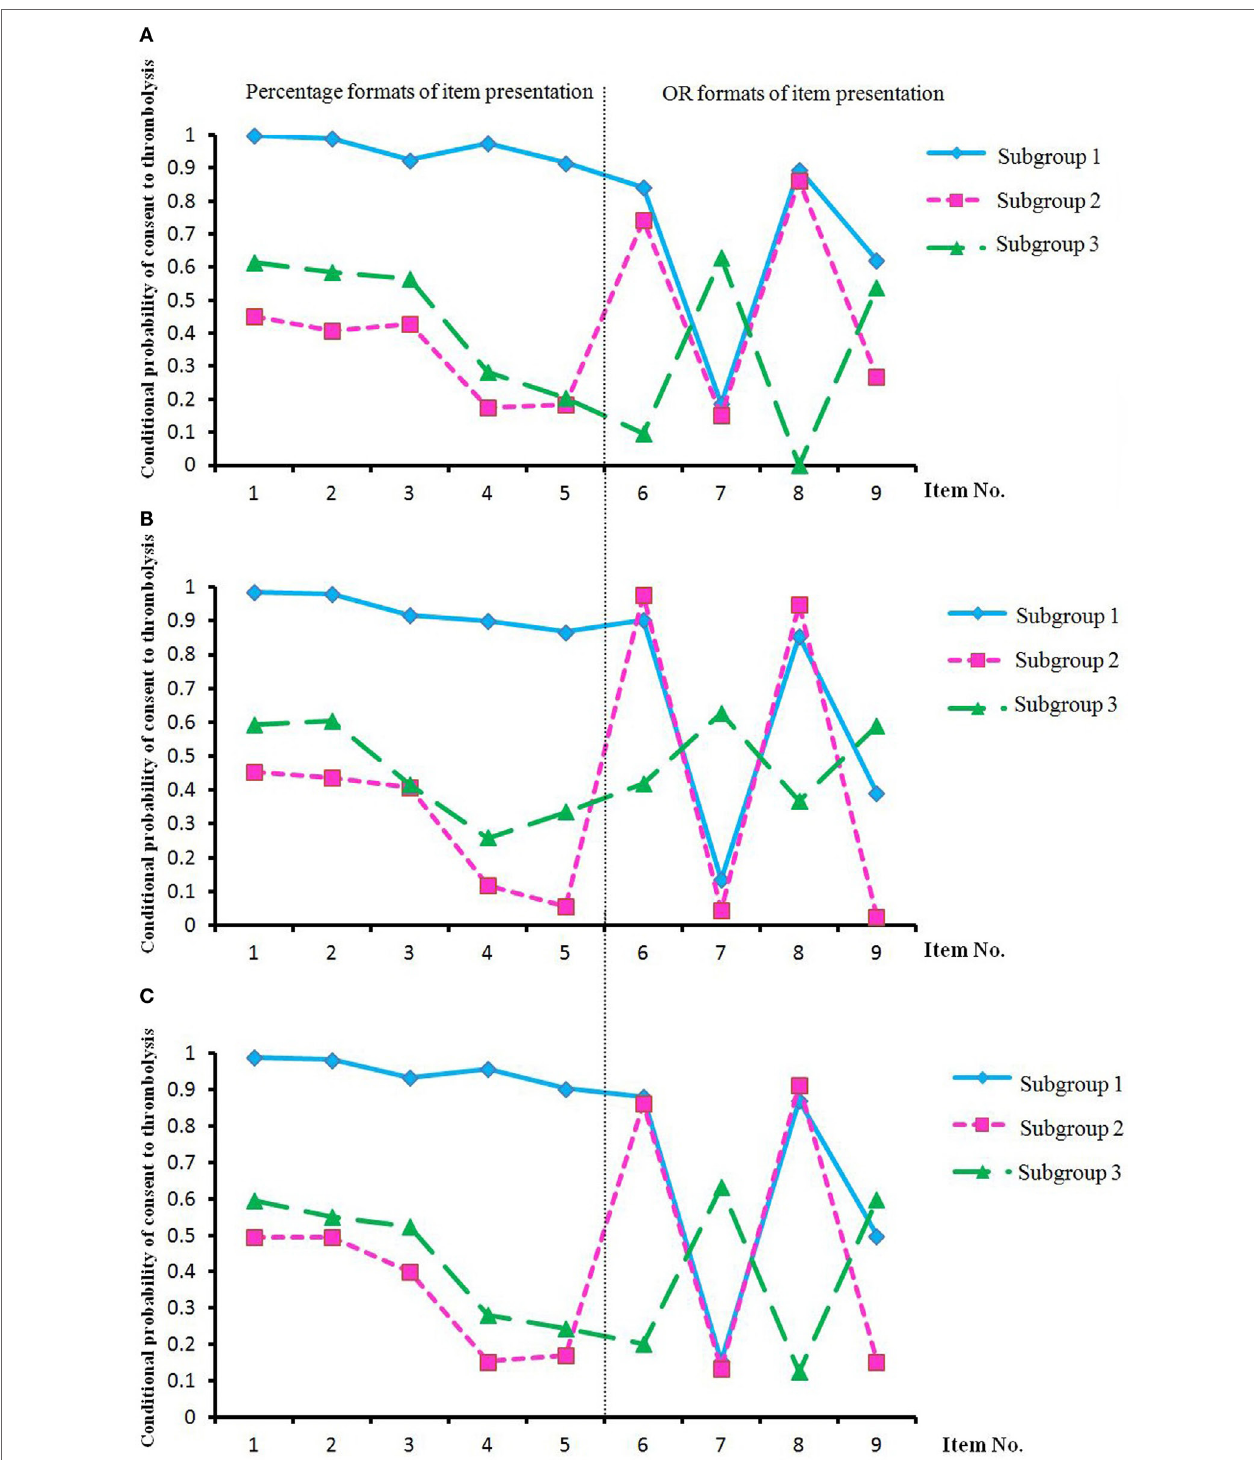
FigUre 1 | Conditional probability of consent to thrombolysis a in three subgroups of participants b in the negative-framing group (a) , the positive-framing group (b) , and both groups (c) . Abbreviations: subgroup 1, consent to thrombolysis subgroup; subgroup 2, objection to thrombolysis subgroup 1; subgroup 3, objection to thrombolysis subgroup 2; OR, odds ratio. a The conditional probability of consent to thrombolysis for each item was calculated via latent class analysis (LCA), and high conditional probability indicated that the participants had more favorable attitudes toward thrombolysis, e.g., the participants in the consent to thrombolysis subgroup. b The subgroup classification was determined based on LCA after randomization of positive or negative framing and the completion of the nine items.